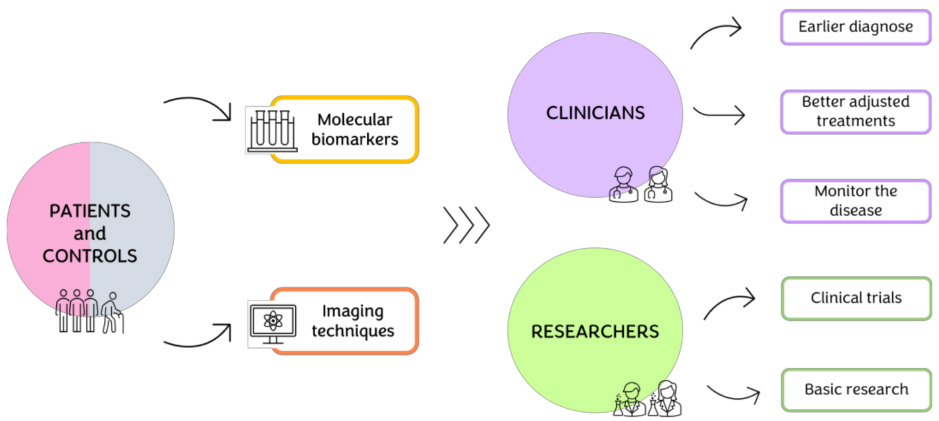
Figure 1. Primary goals for the development and use of molecular biomarkers and imaging techniques in